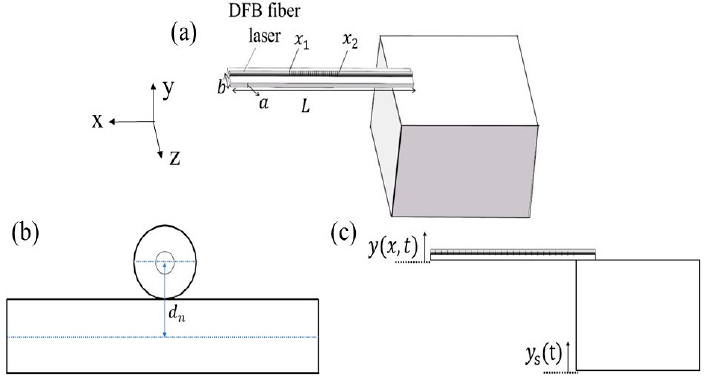
Figure 3. The structure of the cantilever. ( a ) Geometry diagram, ( b ) cross-sectional schematic, and ( c ) displacement diagrams. ( c ) displacement